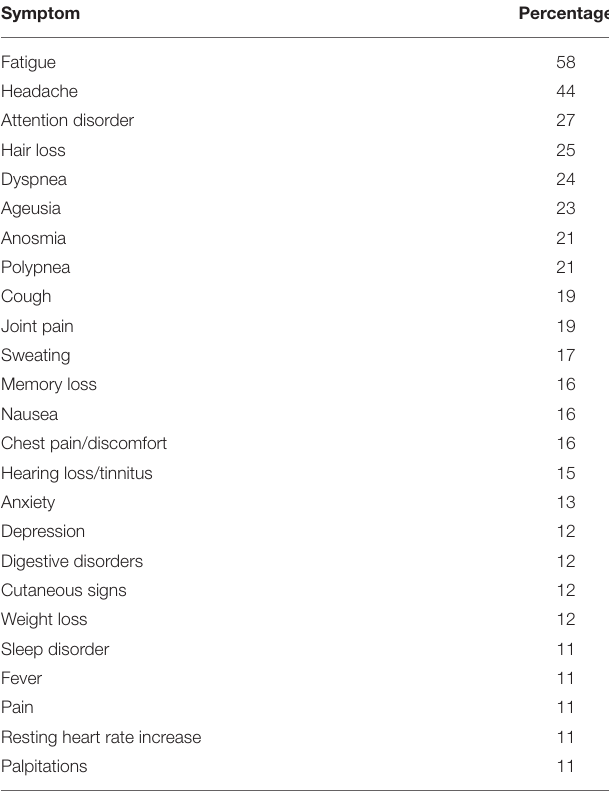
TABLE 1 | Common symptoms of long